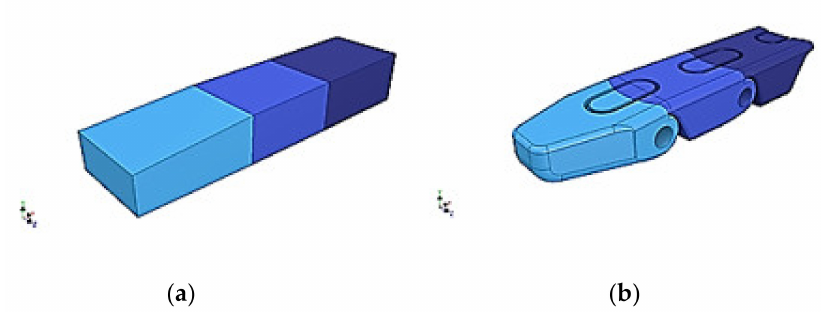
Figure 6. CAD development of phalanges: ( a ) rectangular geometry, ( b ) phalanges.